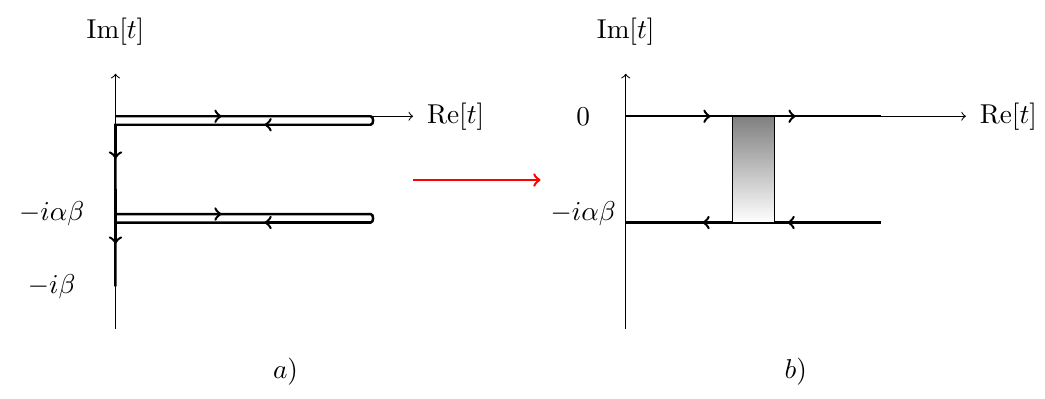
Figure 5 . A pictorial representation of a general time contour ( a ) and of the 4-points function in the ladder approximation ( b ). The external legs lay on the (cid:12)rst time fold and the second time fold. On the contrary, the rung joins the two time folds and include Wightman functions which by de(cid:12)nition are contour